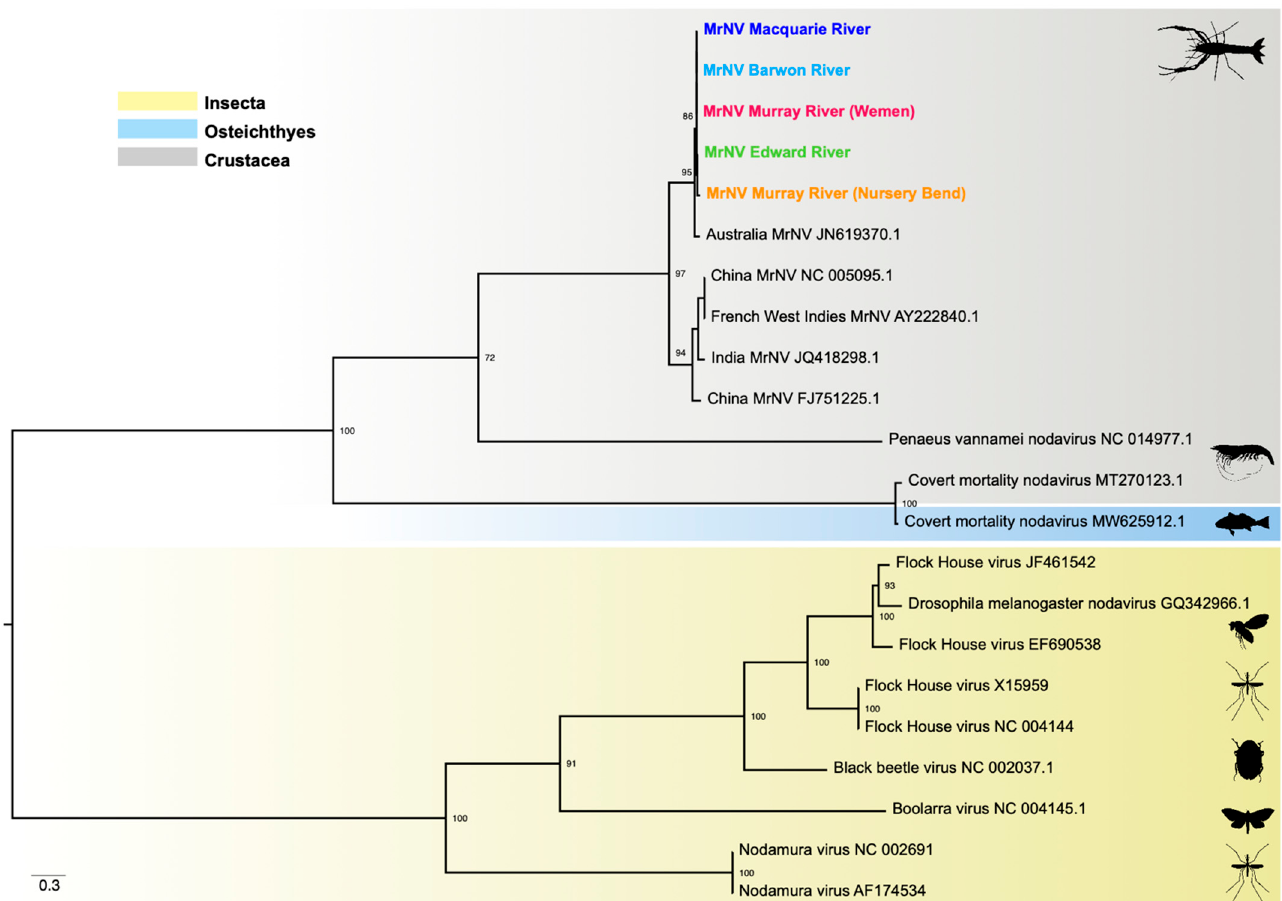
Figure 5. Maximum likelihood tree of the capsid gene (1116 bp) of MrNV and related alphanodavirus sequences. Detected viruses are colour-coded to match Figure 1. The phylogeny is midpoint-rooted for clarity only and scale bar represents nucleotide substitutions per site. Tip labels represent virus name and NCBI/GenBank accession ID.